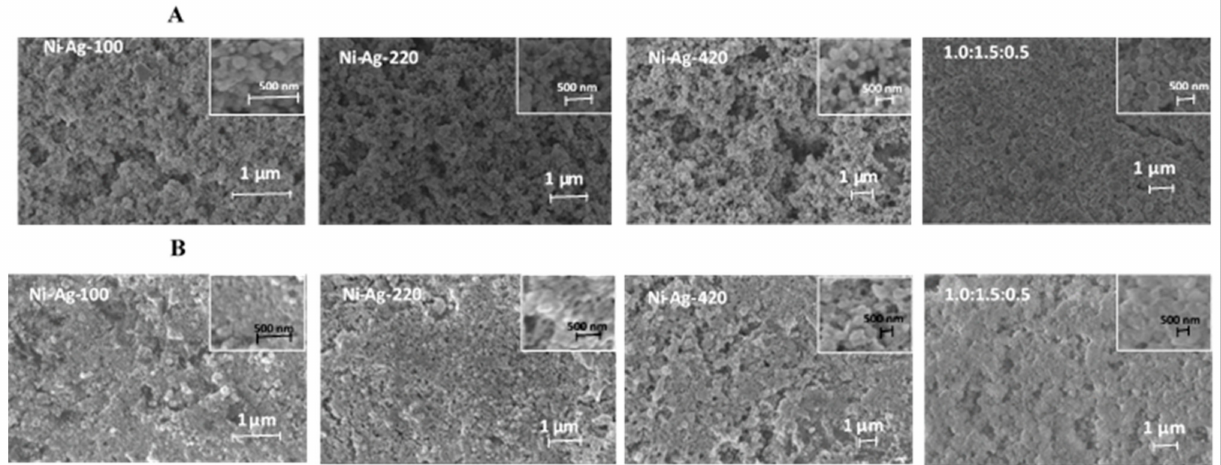
Figure 11. SEM images of metallic coatings formed by individual Ni-Ag NPs with different average sizes and by their mixture at an optimal weight ratio (1.0:1.5:0.5): ( A ) after drying at 60 ◦ C for 10 min and ( B ) after sintering at 300 ◦ C for 30